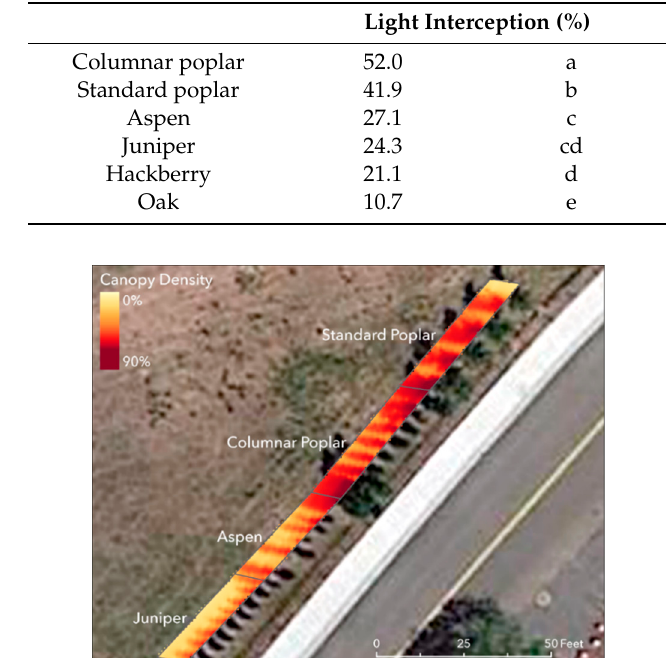
Table 3. Canopy density of windbreaks as determined by light interception. Values are the percent of light intercepted by the canopy, with measured area based on sun angle (shadow length).